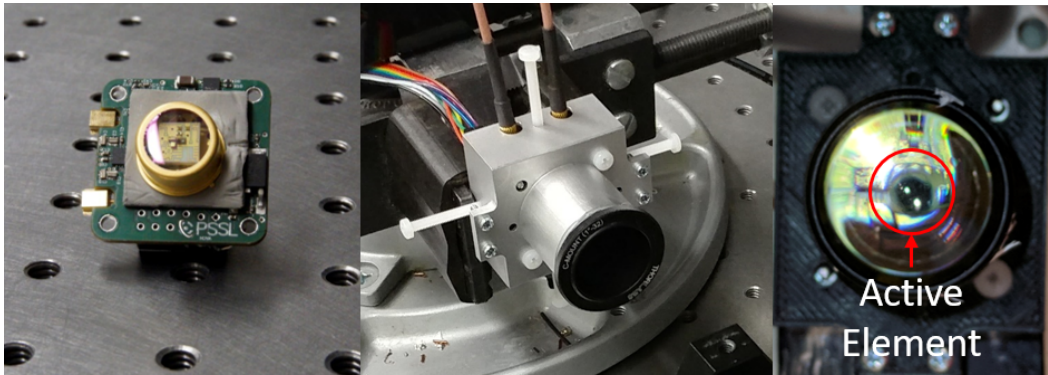
Figure 9. The left picture shows the NOVA receiver board used in laboratory testing. The center picture is the NOVA receiver board inside of its housing for both thermal dissipation and positioning of the focusing lens. The right photo is looking at the active element through the focusing lens which increased the APD effective active area size from 200 µ m to ∼ 5 mm. The focusing lens was aligned to this magnification ( ∼ 25 × ) in order to have an effective active area larger than the 3.6 mm collimated amplifier output signal and maintain low laboratory alignment